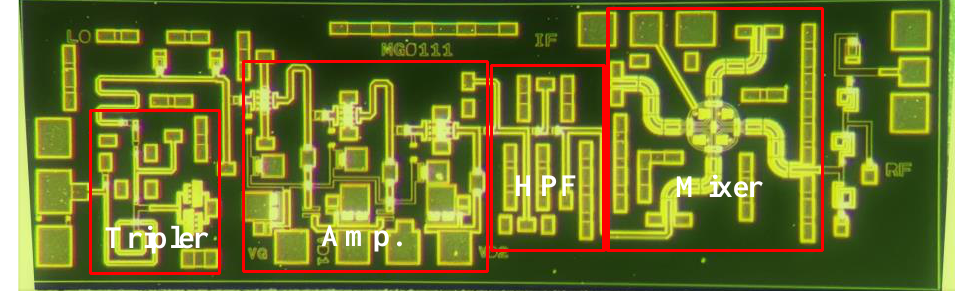
Figure 7. Chip micrograph of the channel emulator.